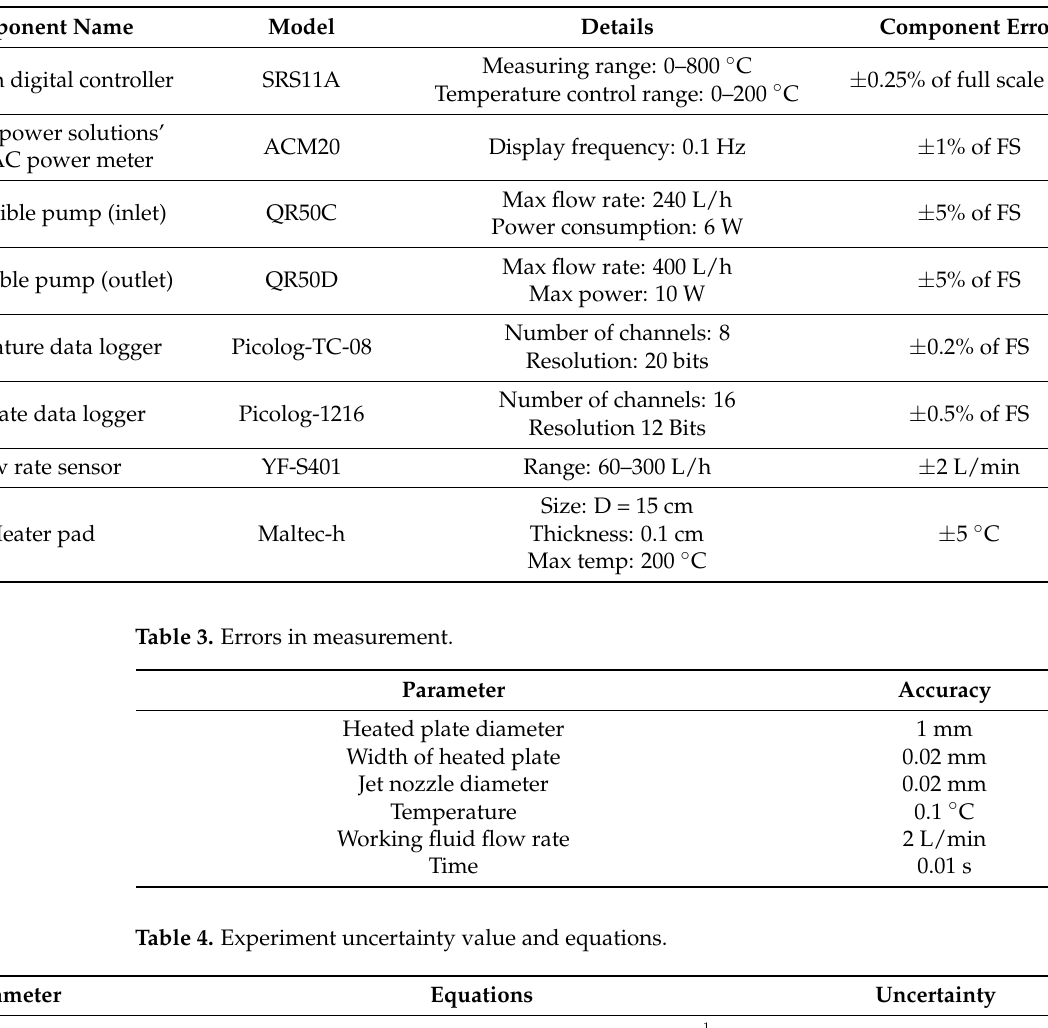
Table 2. Components details of jet impingement system.